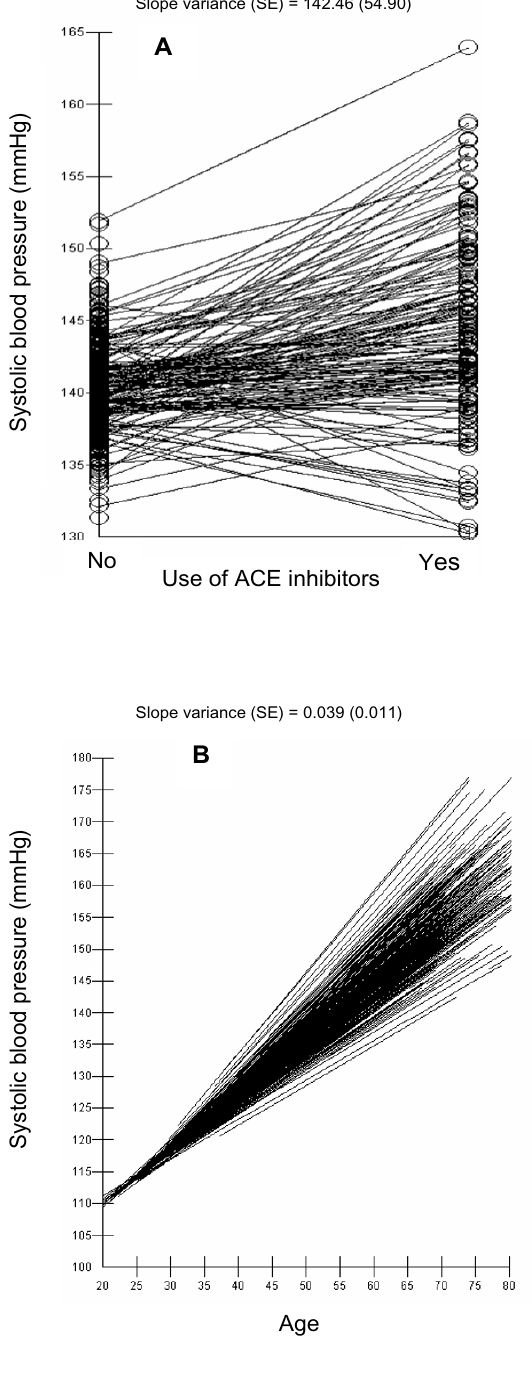
Figure 1 shows the differences in the slope (each line represents a family) of the association between on the one hand age (A) and use of ACE inhibitors (B) and other hand SBP level. Simple visual observation suggests that there is considerable familial heteroge- neity (i.e., family-individual interactions) in those associations. Observe that the regression lines are model predictions obtained in model